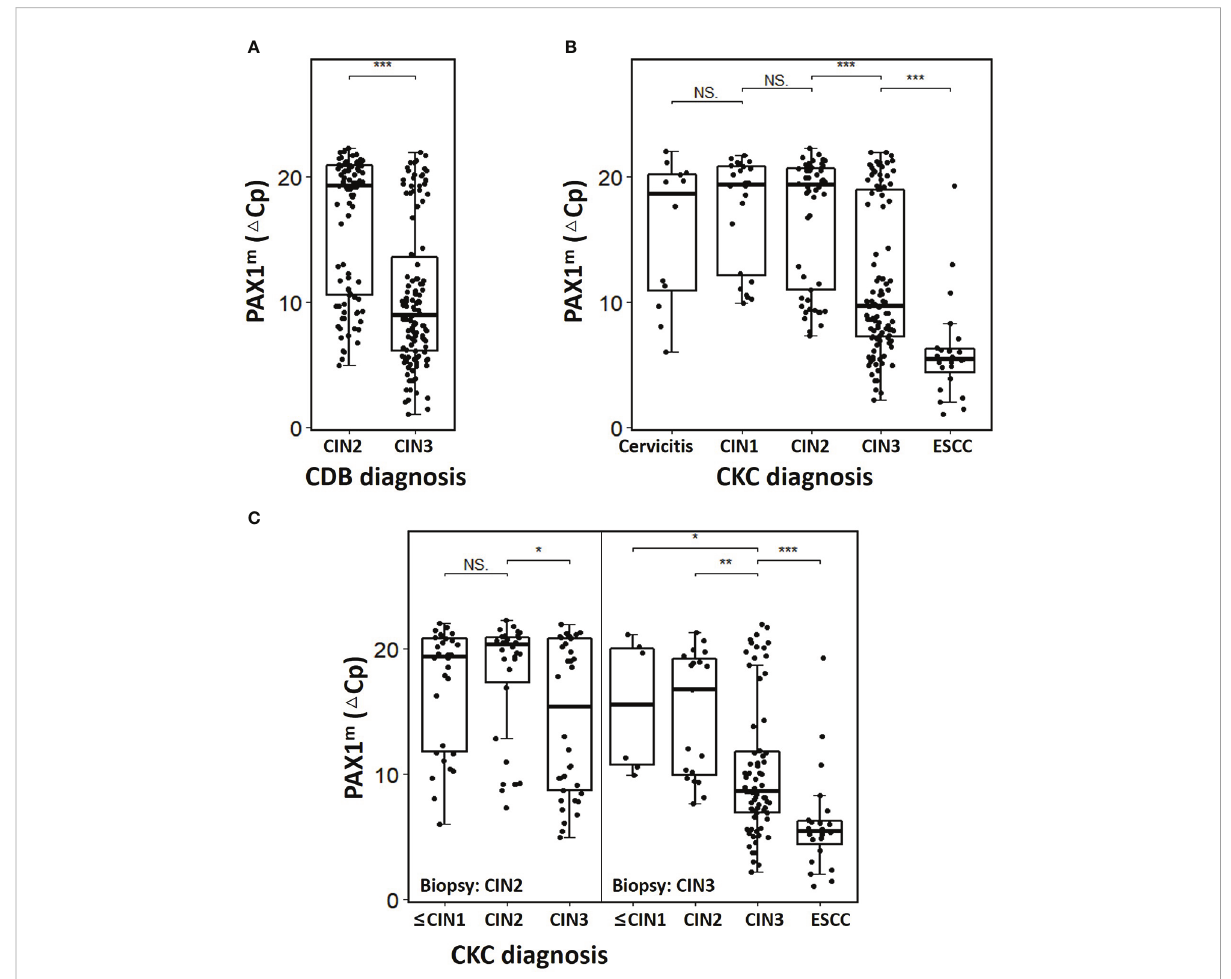
FIGURE 1 The PAX1 m distribution of cervical lesions diagnosed by CDB and CKC. (A) Comparison of D Cp PAX1 levels of CIN2 and CIN3 diagnosis by CDB; (B) Comparison of D Cp PAX1 levels of different cervical lesions diagnosed by CKC; (C) Comparison of D Cp PAX1 levels changing in upgraded, maintained, or degraded lesions after CKC. The middle line is the median; the box shows the inter-quartile range (IQR), and the whiskers extend to, at most, 1.5 times the IQR. *p<0.05, **p<0.01, ***p<0.001, NS: not signi fi cant.